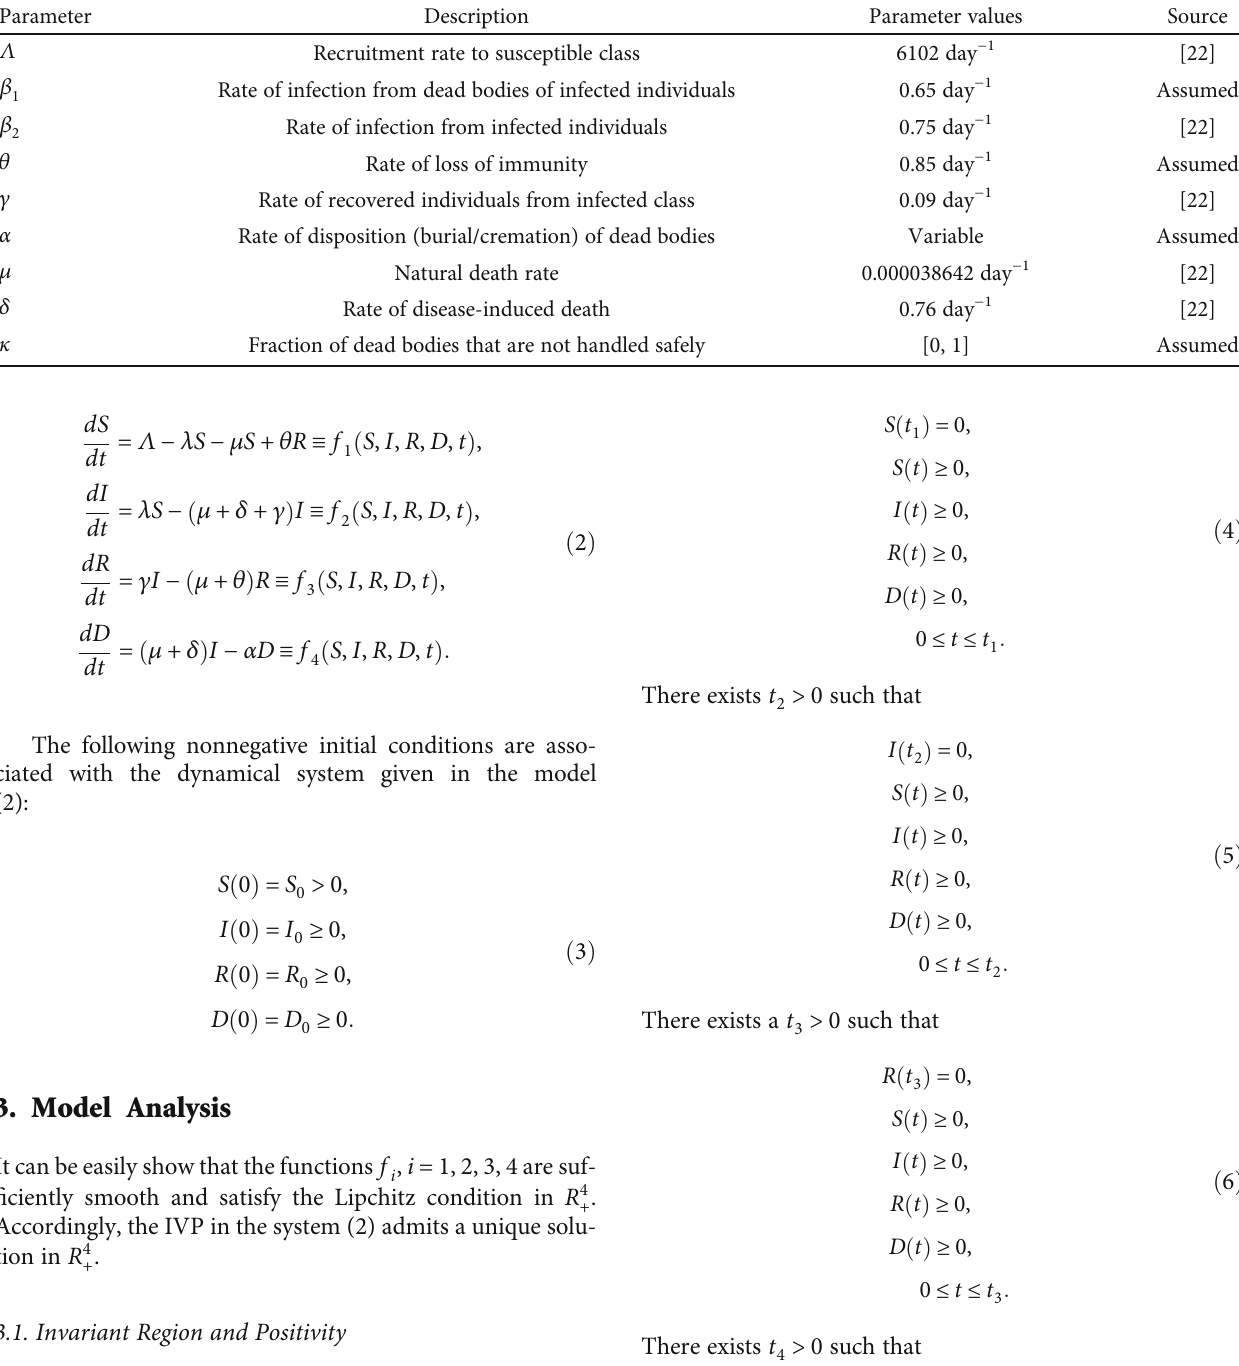
Table 1: Description and values of